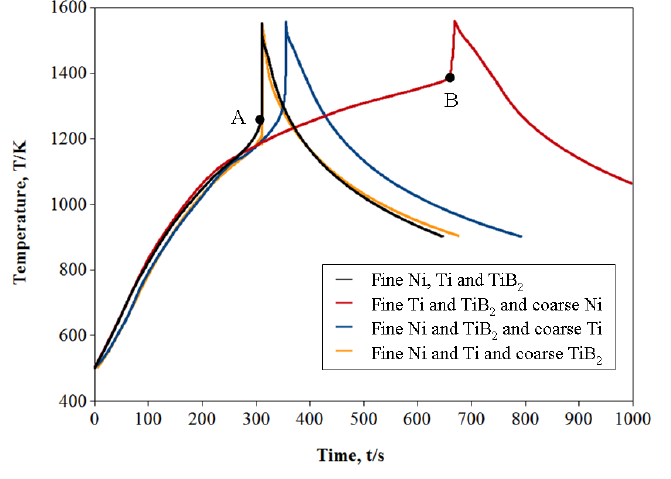
Figure 1. Temperature profile of the specimens made with various powder sizes of Ni, Ti and TiB